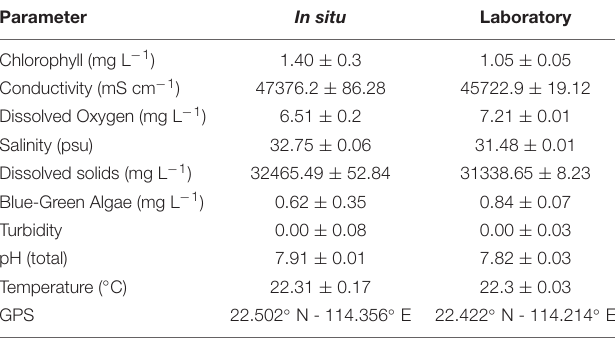
TABLE 1 | Environmental conditions of seawater at different locations ( in situ vs. laboratory) on 13th April 2018. Parameter In